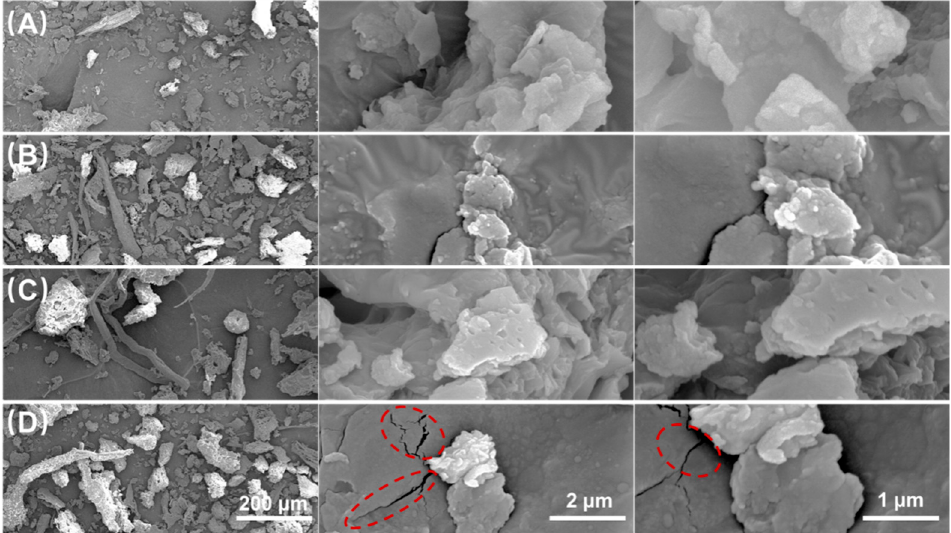
Figure 6. SEM images of ( A ) pristine tobacco leaf and tobacco leaf after eugenol release experiments conducted at ( B ) 220 °C, ( C ) 250 °C and ( D ) 260 °C.